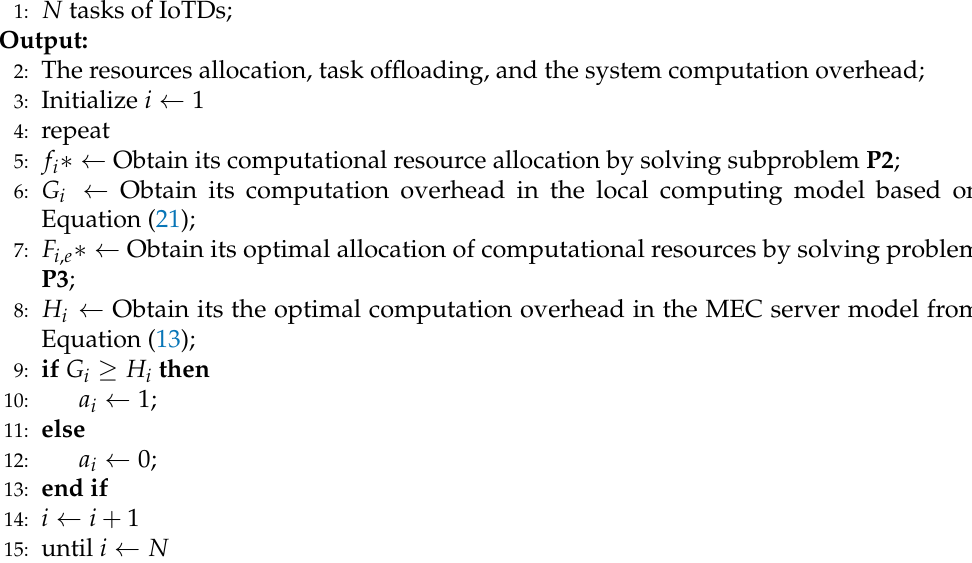
Algorithm 1 The Proposed Algorithm in the Security-Aware MEC